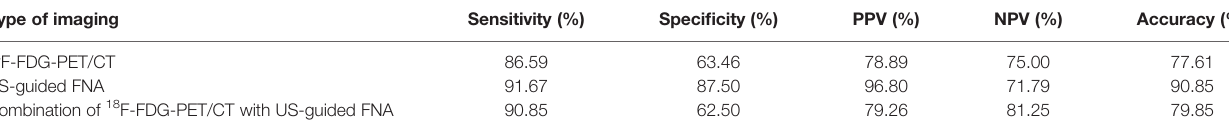
TABLE 4 | Diagnostic performance of PET-CT and FNA in the assessment of lymph node metastasis. Type of imaging